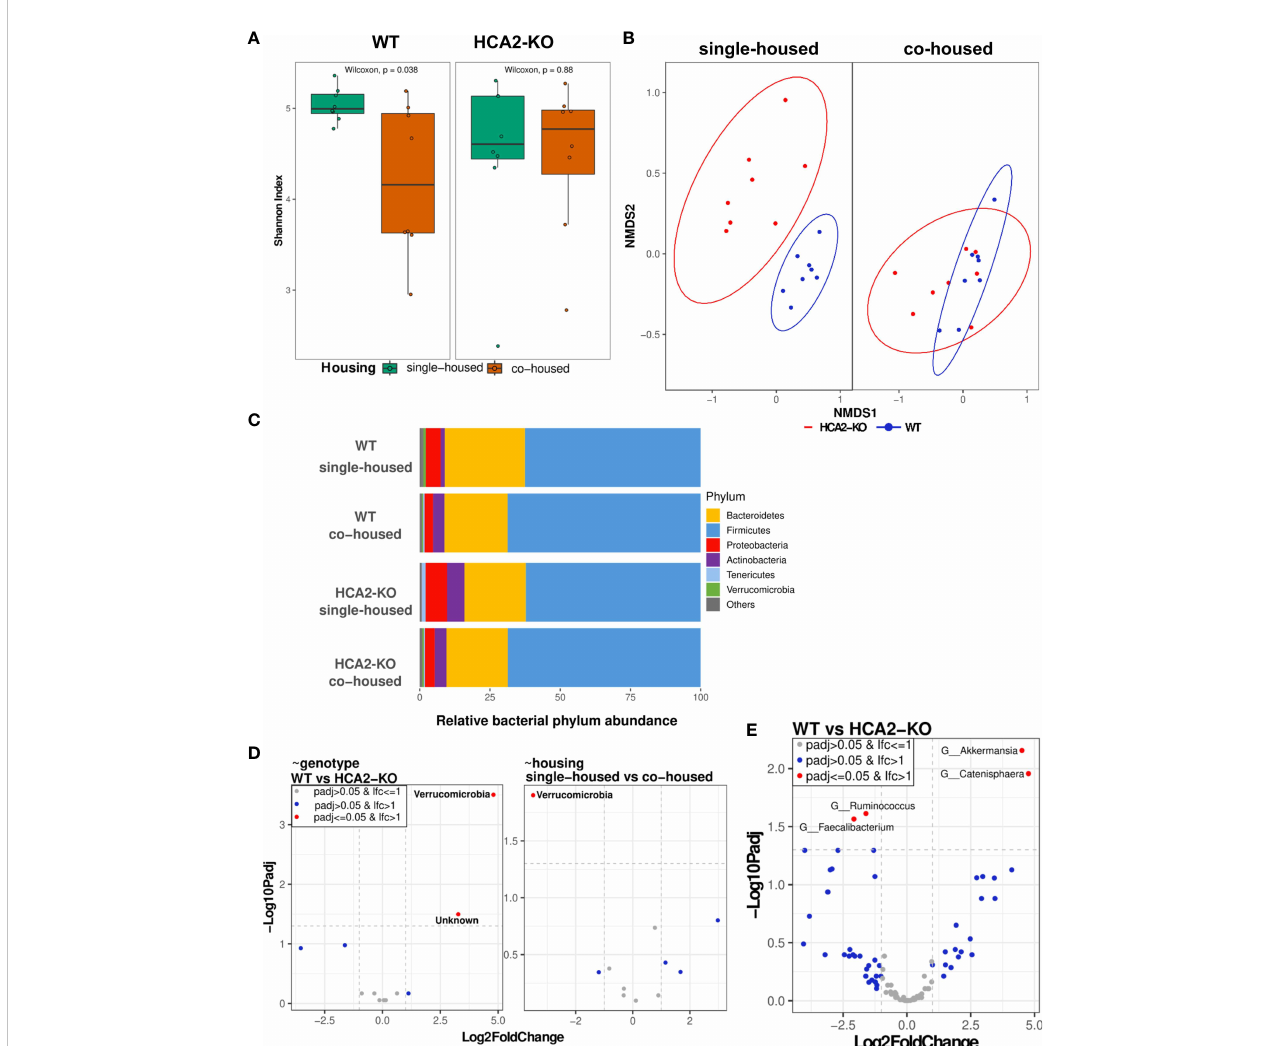
FIGURE 6 Skin dysbiosis in the absence of HCA2 predisposes mice to psoriasis-like in fl ammation. WT mice were co-housed with HCA2-KO mice for 1 month. 16S rRNA sequencing was performed. (A) Alpha diversity (Shannon Index) between WT and HCA2-KO mice, while colors indicate housing conditions. (B) Beta diversity calculated with Bray-Curtis dissimilarity and displayed by non-metric multidimensional scaling (NMDS) between single- and co-housed mice, while colors indicate genotype. (C) Relative bacterial abundance at phylum level split for the different genotype and housing conditions. (D) Differential abundance at phylum level based on linear models by genotype (left) and by housing (right). Volcano plot visualizes – Log10 Benjamini-Hochberg adjusted p-value over Log2FoldChange (LFC). LFC is depicted as relative to HCA2-KO (left) and co-housed (right), i.e. a negative LFC displaying a reduced abundance in WT compared to HCA-KO mice in the left graph and a reduced abundance in single-housed compared to co-housed mice in the right graph. (E) Differential abundance at genus level based on linear models by genotype. Volcano plot visualizes – Log10 Benjamini-Hochberg adjusted p-value over Log2FoldChange. A negative LFC shows genera with reduced abundance in WT mice, whereas a positive LFC shows genera more abundant in WT mice. No genus was signi fi cantly differentially abundant by housing (data not shown). Each group contained 8 animals. Data are presented from one of three independent